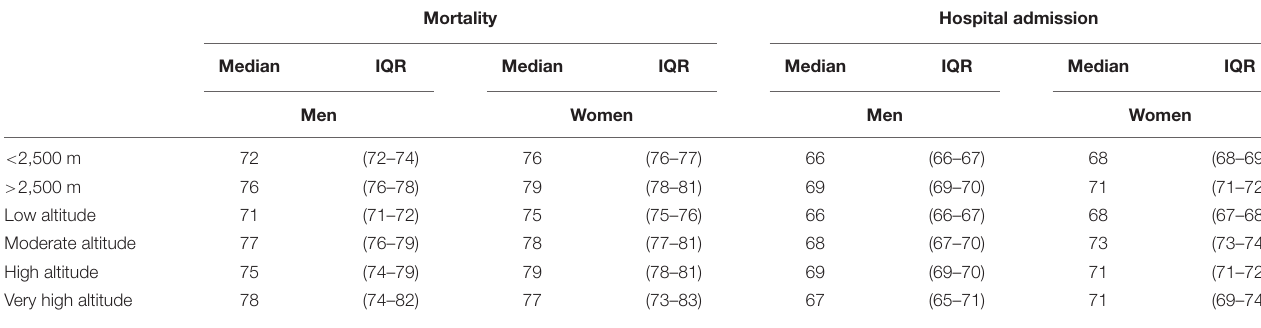
TABLE 1 | Descriptive analysis of age median (in years) between deaths and hospital admission due to all-causes of stroke in Ecuador at different elevation